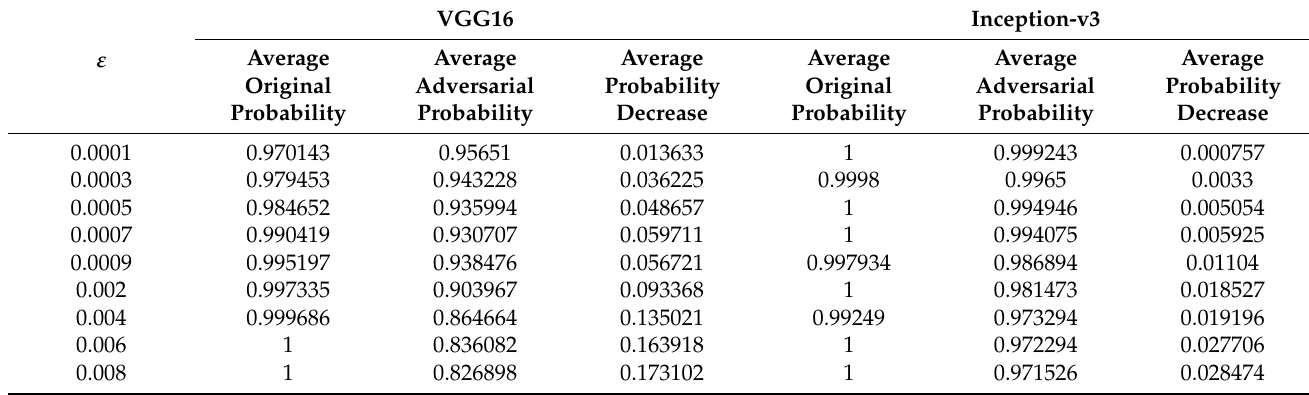
Figure 13. Sample drop of class probability score for successfully classified adversarial chest CT images. Table 9. Average drop of predicted correct class probability for adversarial chest CT images.